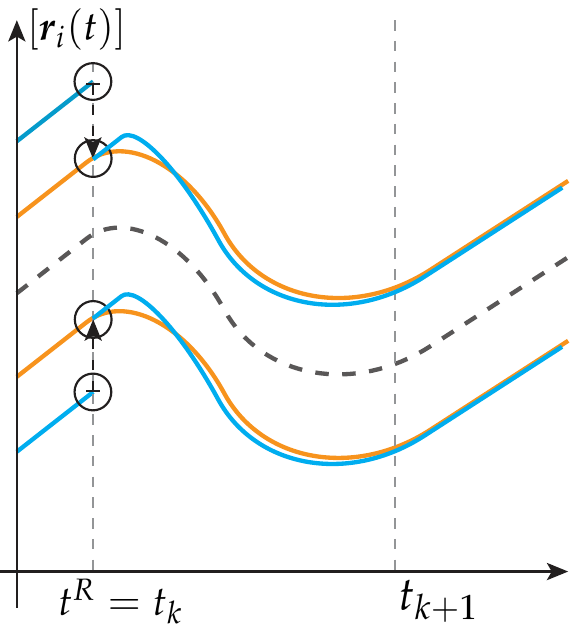
Figure 3. A whole re-initialization during time step t R = t k